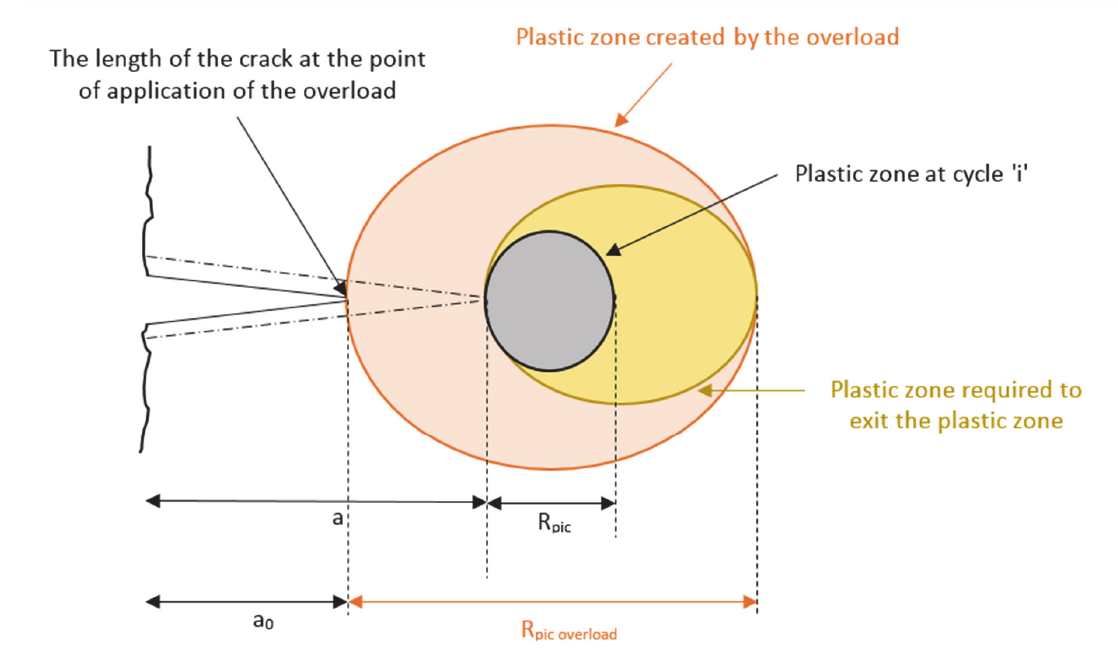
Figure 1: Willenborg retardation